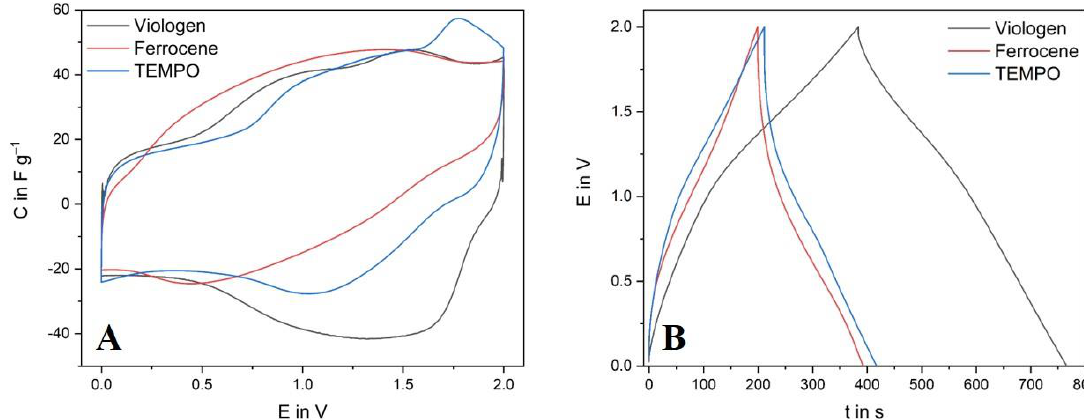
Figure 5. ( A ) Cyclic voltammograms of 0.1 M RAILs in Pyr 14 TFSI at 0.1 mV s − 1 in symmetrical full-cell setup with AC electrodes. ( B ) Charge/discharge profiles of 0.1 M RAILs in Pyr 14 TFSI at 0.1 A g − 1 in symmetrical full-cell setup with AC electrodes.